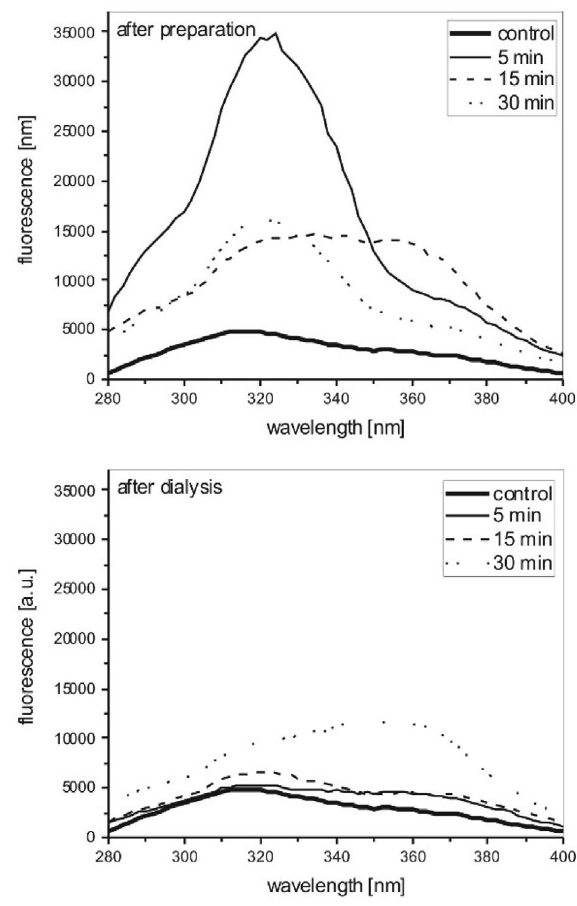
Figure 9. Fluorescence activation spectra of the prepared solutions. The activation is recorded for fluorescence light emitted at 440 nm. Presented are spectra from solutions prepared with different pro- cess duration under a process temperature of 140 °C.